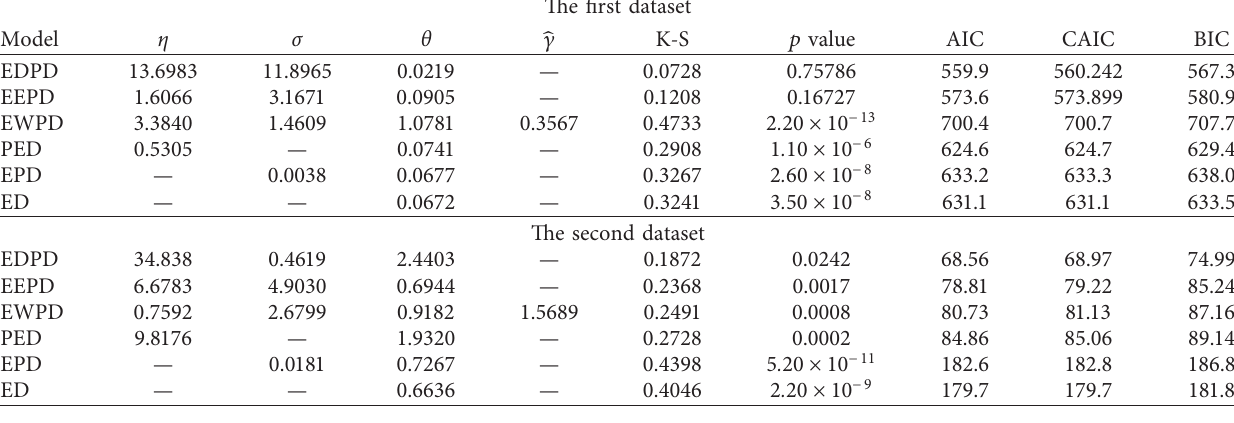
Table 2: The MLEs, K-S statistic, p value, AIC, CAIC, and BIC for the two datasets. The first dataset